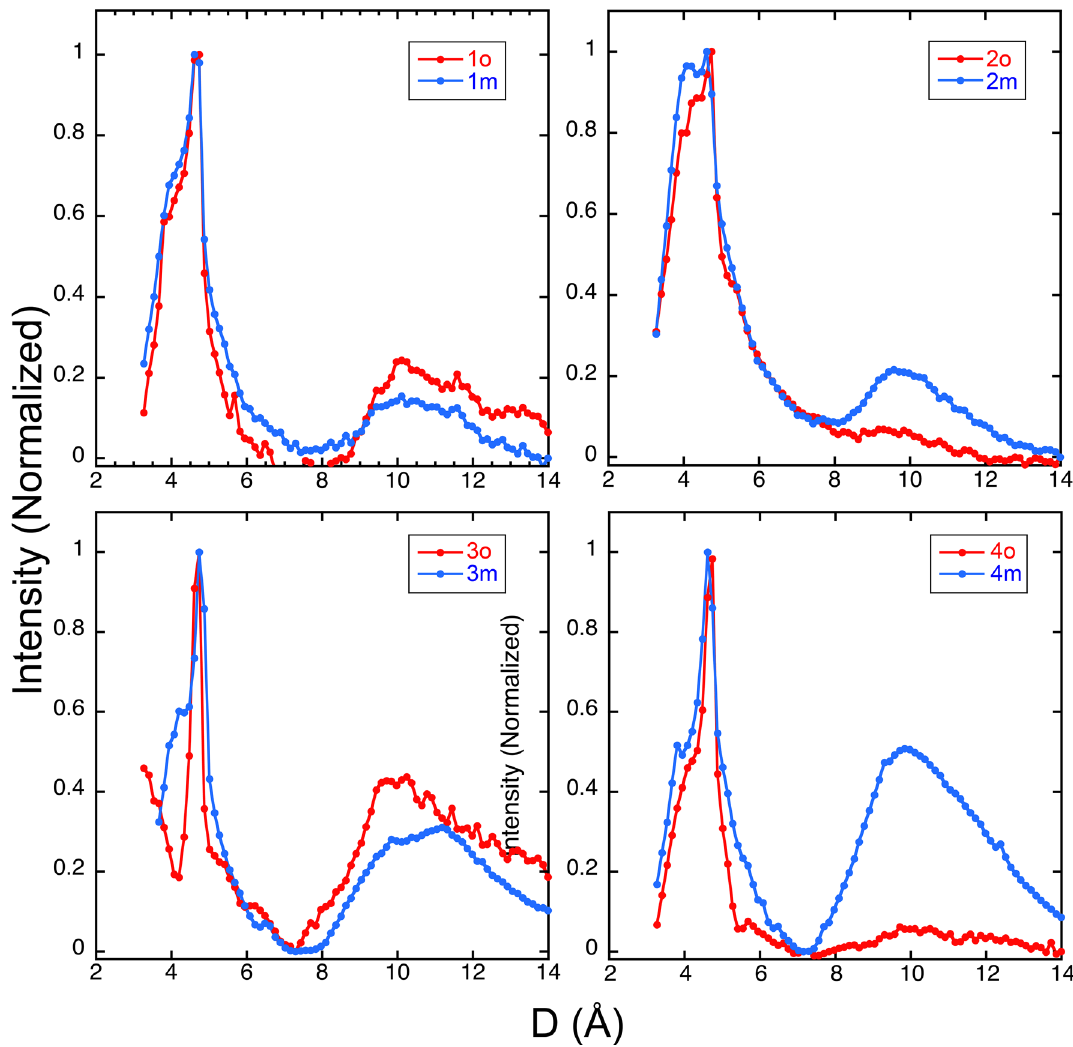
Figure 8. Fiber X-ray diffraction patterns for brain parenchyma- (red) and meninges-seeded (blue) Aβ40 fibrils. These show also showed reflections at 4.6–4.7 and 9.2–11.6 Å common to